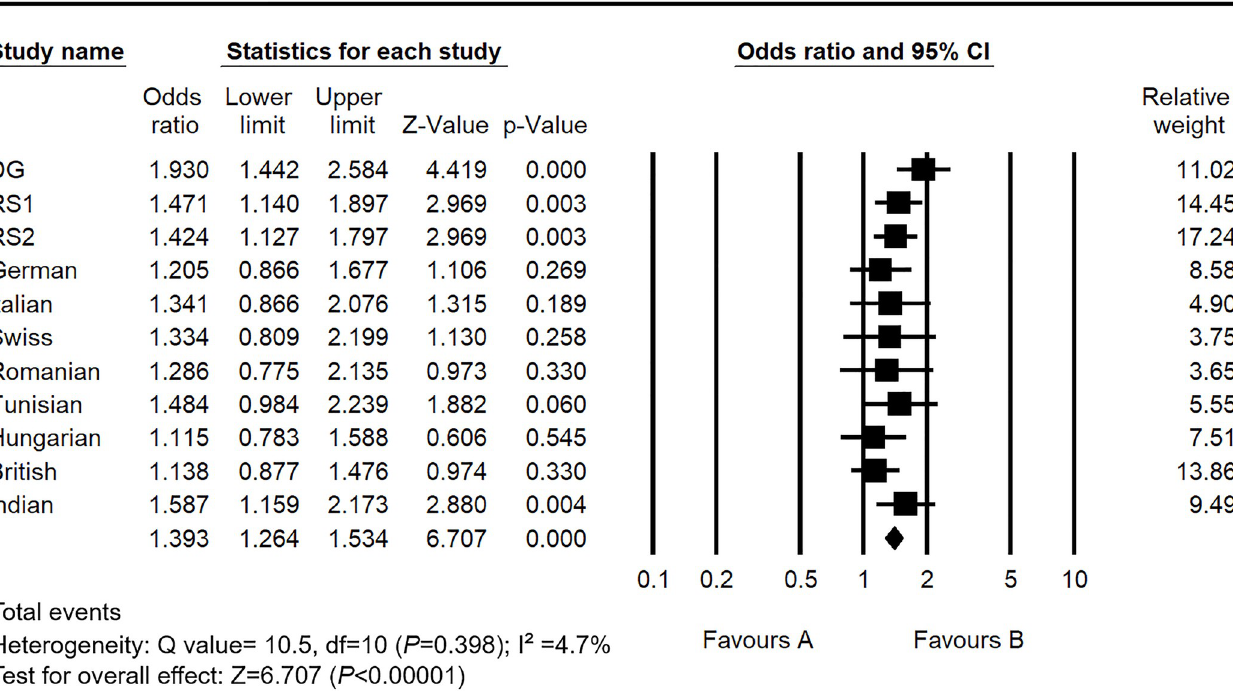
Fig 2. Meta-analysis plot for rs3914132 SNP in RELN gene. The point estimates of the odds ratio (OR) for each study are listed. Graphically, the 95% confidence interval for each study is given by a horizontal line, and the point estimate is given by a square whose height is inversely proportional to the standard error of the estimate. The common OR, is drawn as a diamond with horizontal limits at the confidence limits and width is inversely proportional to its standard error. Populations included in this meta-analysis are provided from the genome wide association study (DG: Discovery group, RS1: Replication Set 1, RS2: Replication Set 2) (Schrauwen et al., 2009), a follow up study in 4 European populations (GER: German, ITA: Italian, CH: Swiss, ROM: Romanian) (Schrauwen et al., 2010), Tunisian, Hungarian & British populations (Khalfallah et al., 2010; Sommen et al., 2014 and Mowat et al., 2018) and Indian population from the present